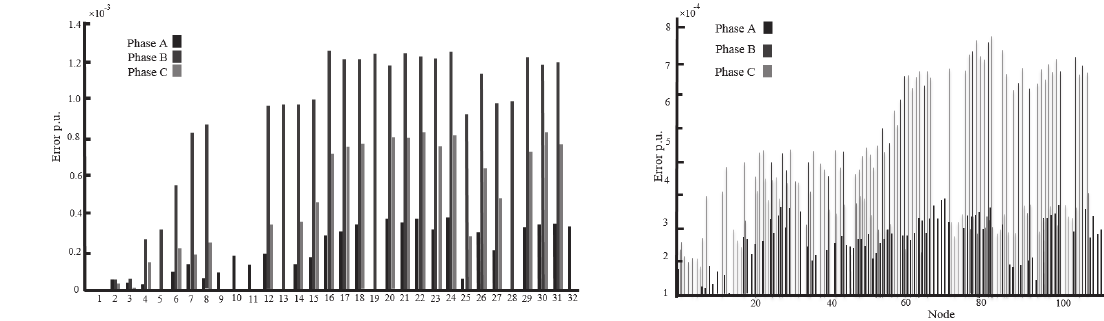
Fig. 4. Difference in voltage of En22k4-IEEE123 compared with benchmark